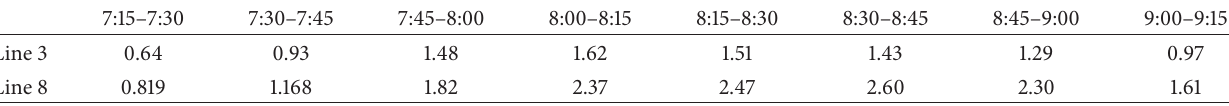
Table 2: Average inbound passenger flow density at facility during peak